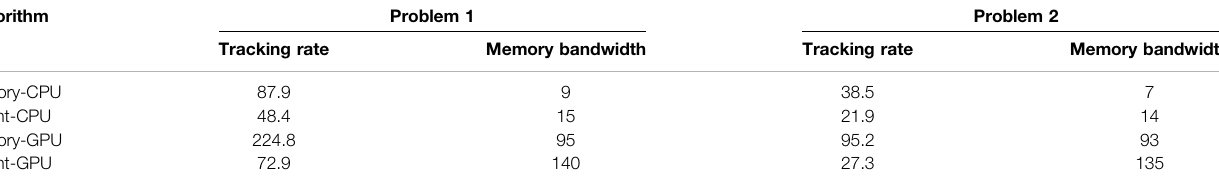
TABLE 3 | Tracking rate (10 4 n / s ) and achieved memory bandwidth ( GB / s ) of history-based and event-based algorithms on CPUs and GPUs for problem1 and problem 2. Algorithm